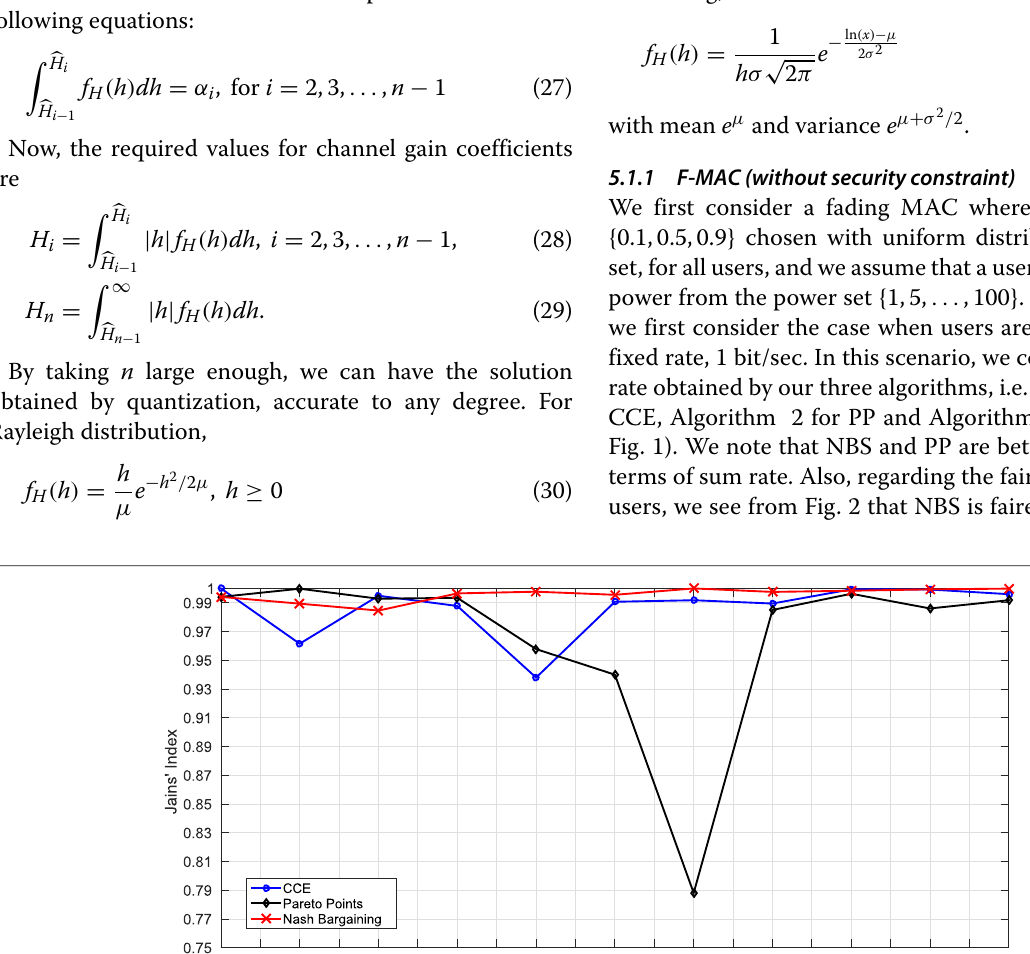
{ α α . . . , α } . Let (cid:6) H n 1 , 2 ,